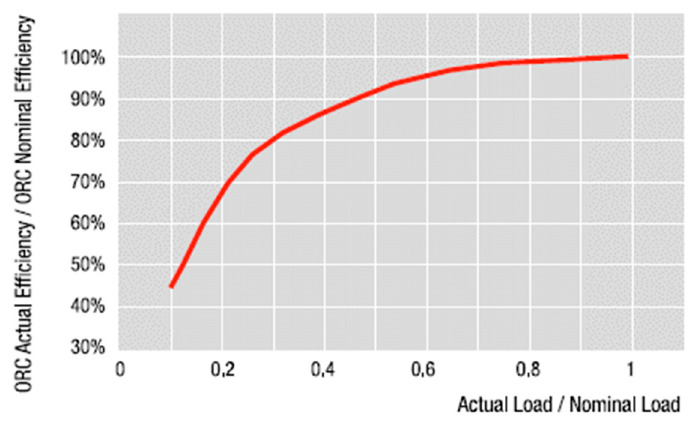
Figure 8. Organic Rankine Cycle (ORC) energy efficiency at partial load operation [50].